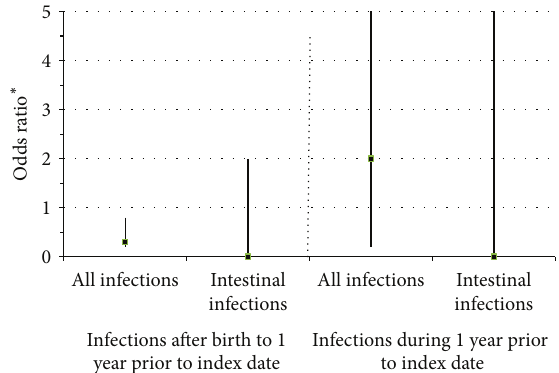
Figure 2: Odds ratios for hospitalized infections comparing ulcer- ative colitis cases with controls. ∗ Compared with controls using conditional logistic regression accounting for the matching